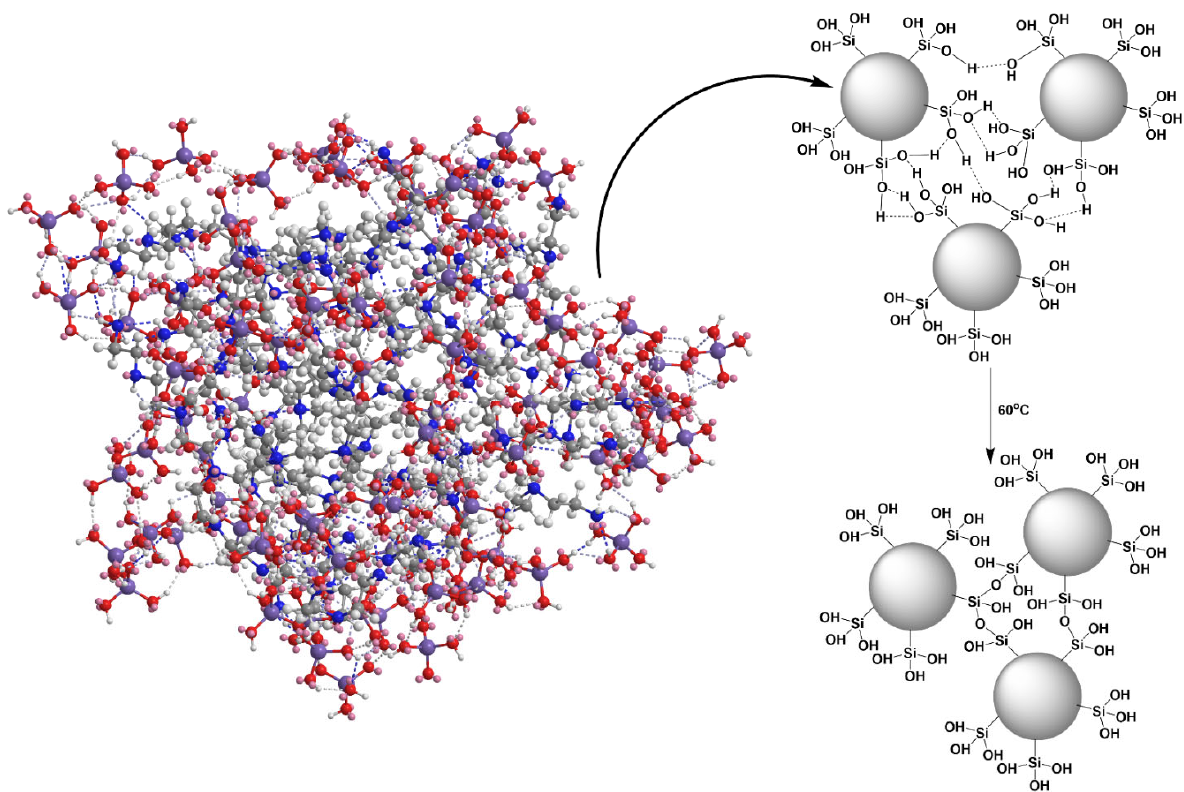
Figure 1. Schematic representation of Ag Nps nucleation inside the cavities of hyperbranched PEI. On the outer surface of PEIs, the functional primary amino groups are capable of interacting with the appropriate reagents. They are ideal scaffolds for biomimetic silicification by the formation of a network of complementary hydrogen bonds with orthosilicic acid (Figure 2), producing ceramics and gels. Hydrogels have many acid (Figure 2), producing ceramics and gels. Hydrogels have many applications, such as applications, such as stationary phases in column chromatography, pharmaceuticals, stationary phases in column chromatography, pharmaceuticals, desiccants, food additives desiccants, food additives moisture indicators, and carriers of active ingredients with moisture indicators, and carriers of active ingredients with controlled-release capabili- controlled ‐ release capabilities. [49,50]. The gentle dehydration ‐ drying of silanol groups ties. [49,50]. The gentle dehydration-drying of silanol groups into siloxanes affords silica into siloxanes affords silica xerogels. These versatile materials are non ‐ toxic and xerogels. These versatile materials are non-toxic and biocompatible [51,52]. They are more biocompatible [51,52]. They are more appropriate for carrying sensitive active ingredients, appropriate for carrying sensitive active ingredients, for instance, those susceptible to for instance, those susceptible to oxidation due to the very limited water content. oxidation due to the very limited water content. Moreover, the applicability of high Mw Moreover, the applicability of high Mw (25,000–750,000) hyper ‐ branched PEIs in living (25,000–750,000) hyper-branched PEIs in living organisms is very limited, due to their organisms is very limited, due to their toxicity. Coupling with negatively charged toxicity. Coupling with negatively charged orthosilicic acid neutralizes the large topical orthosilicic acid neutralizes the large topical positive charge concentrations, which is the positive charge concentrations, which is the main cause of the adverse side effects [53,54]. main cause of the adverse side effects [53,54].